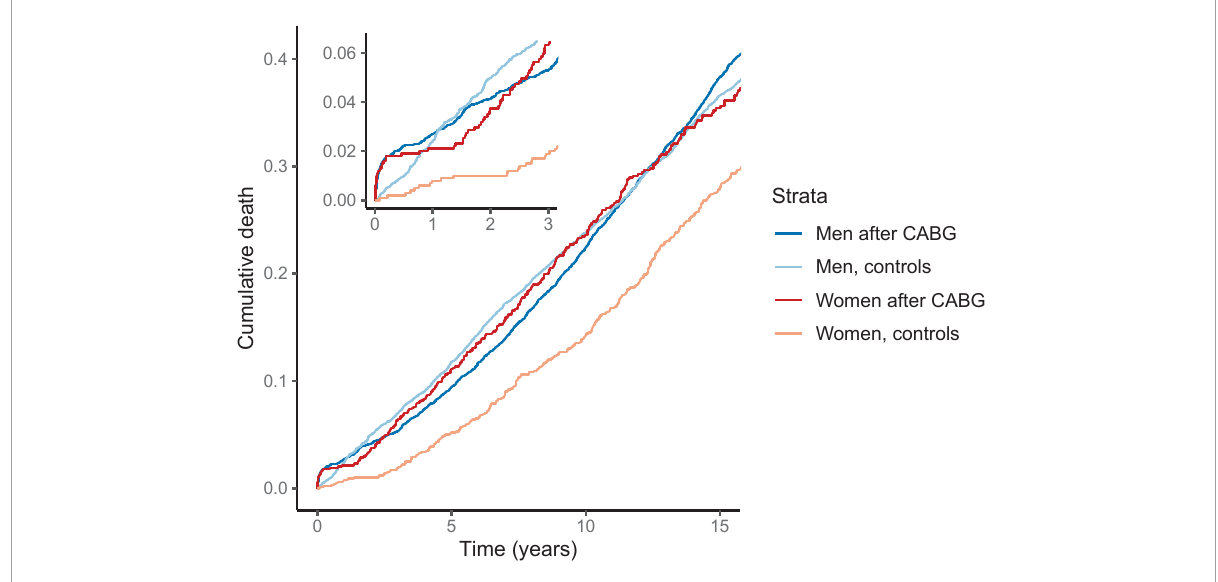
FIGURE1 Cumulative death by sex after coronary artery bypass grafting (CABG). The survival curves are from Kaplan-Meier estimator. We matched the models for age, BMI and smoking status. The risk for death is elevated in women after CABG compared to matched women. In contrast, after 1 year men with CABG had similar risk of death than the matched men in the control group.